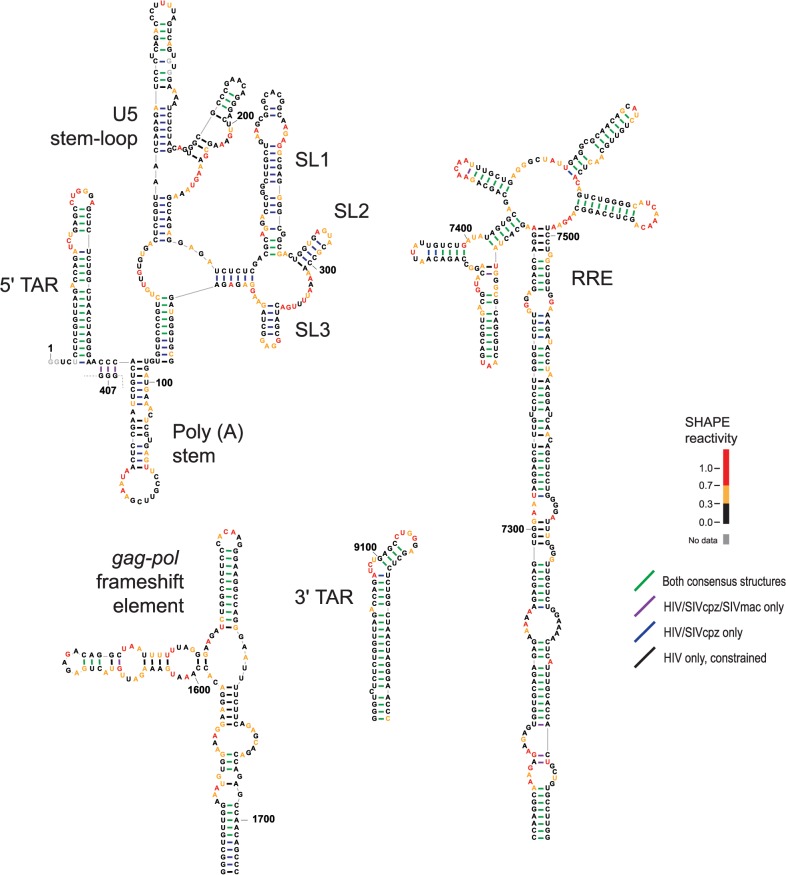
Secondary structure models for RNA elements with prior well-established functions.Secondary structures correspond to the final, fully automated constrained HIV-1 prediction. Other figure annotations are described in the Fig 3 legend.